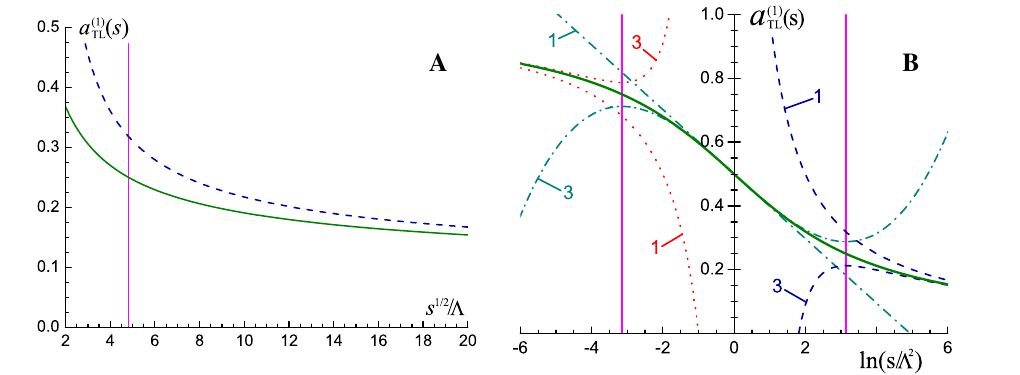
( s ) vals: ln w < − π [Eq. (18), dotted curves], − π < ln w < π [Eq. (19), TL dot-dashed curves], and ln w > π [Eq. (20), dashed curves]. Numerical ( 1 ) ( | s | ) [Eq. (13), dashed labels indicate the highest absolute value of the power of ln w retained s ( 1 ) in the re-expansions on hand. The boundaries of the convergence ranges ( s ) TL of Eqs. (18)–(20) are marked by vertical solid